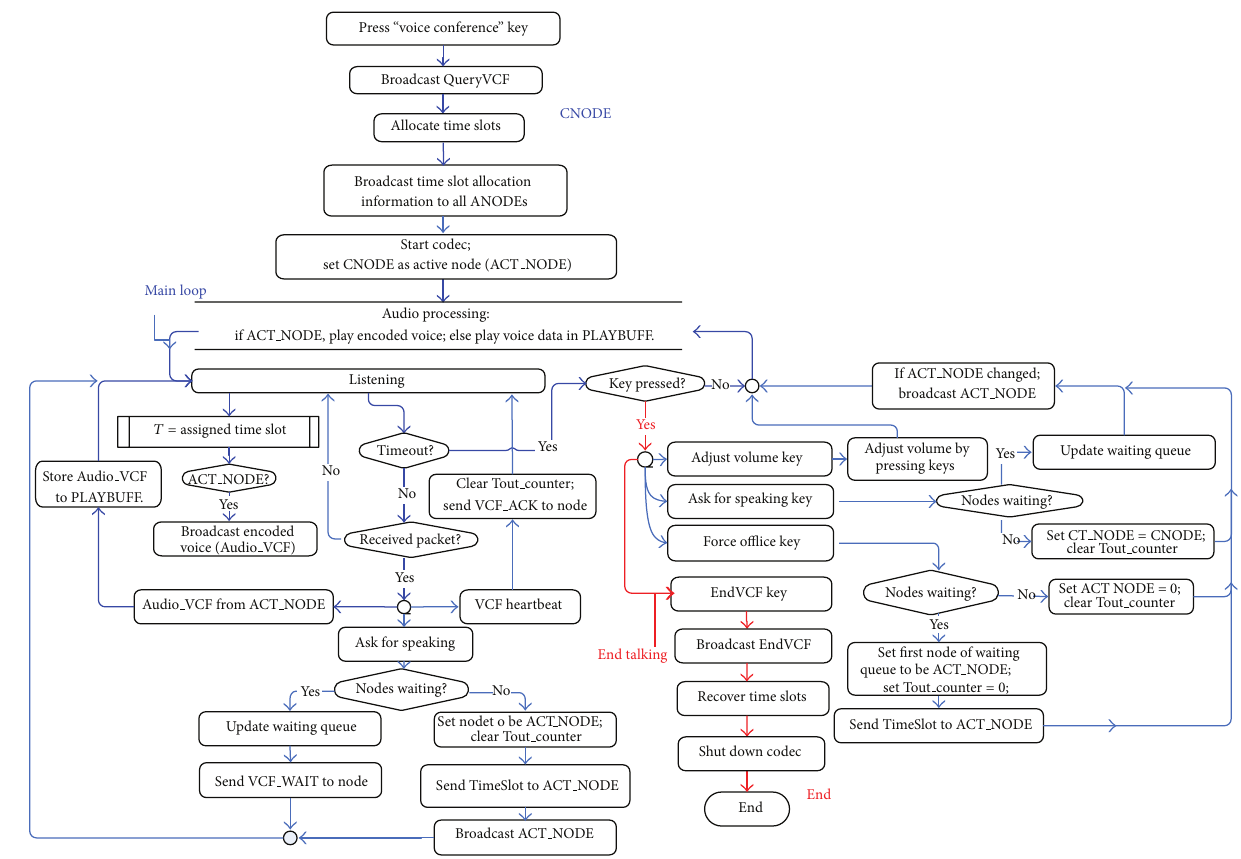
Figure 16: VCF communication